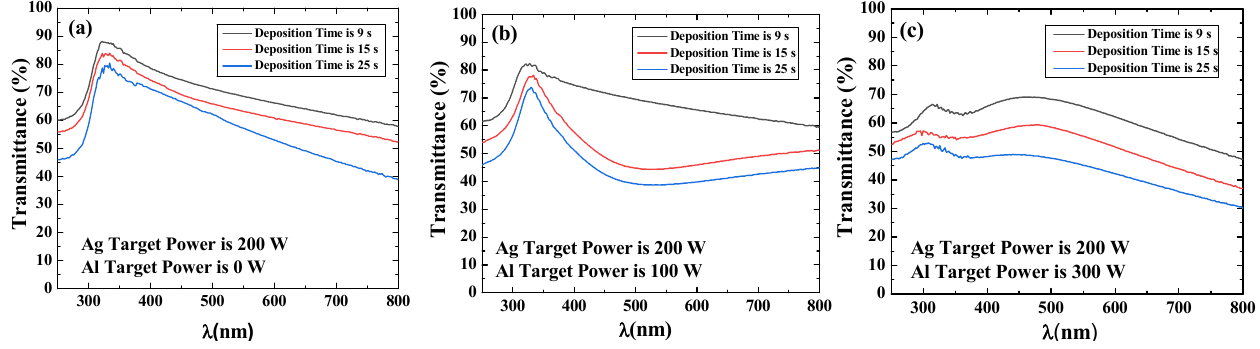
Figure 4. Transmittance results of undoped silver film and Al-doped silver film with different deposition time, and the aluminum target power is ( a ) 0 W, ( b ) 100 W and ( c ) 300 W, respectively.